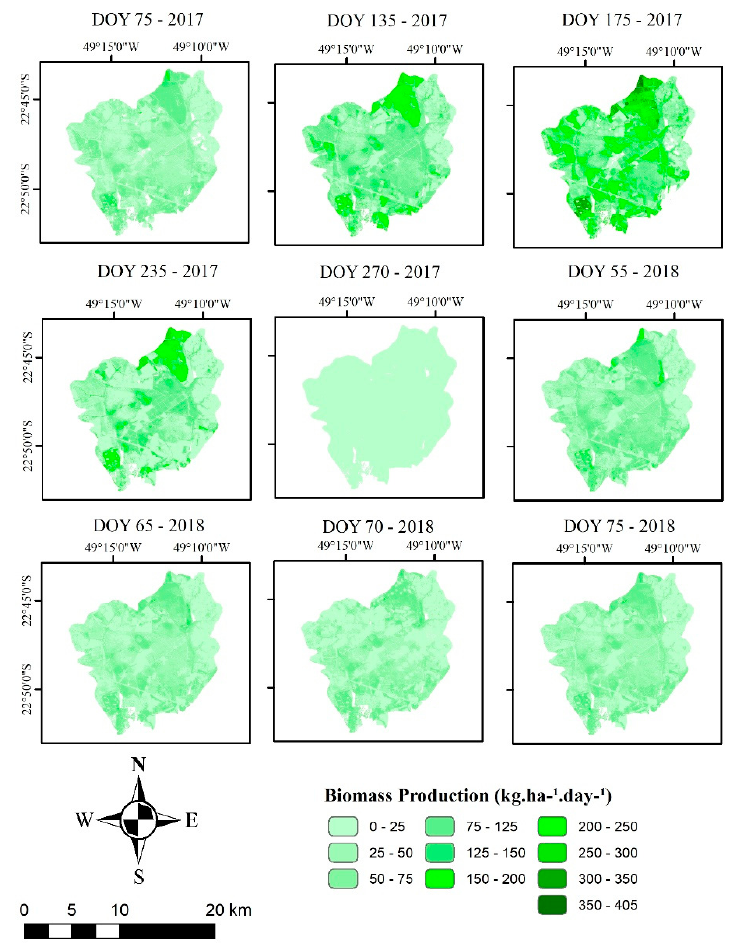
Figure 11. Biomass production (kg · ha − 1 · day − 1 ) between 2017 and 2018 in watersheds with varied land use (DOY = day of year). Table 6. Mean values and standard deviation of the crop coefficient between 2017 and 2018 by land use and day of year (DOY). DOY Sugarcane Crop Pasture DOY